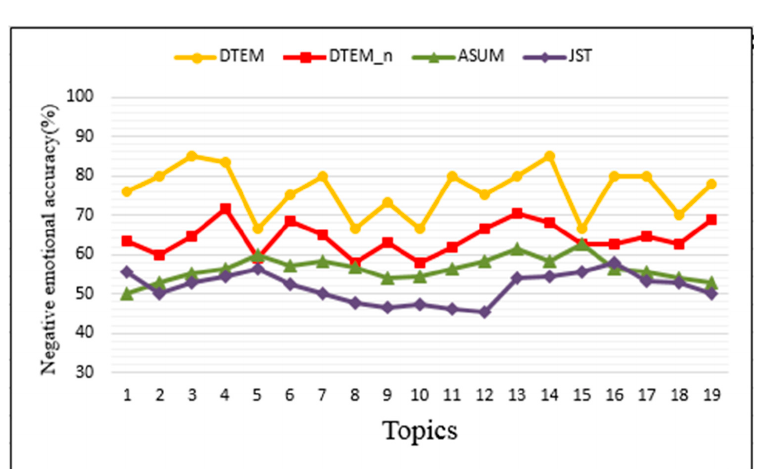
Figure 7. Positive accuracy for each topic.